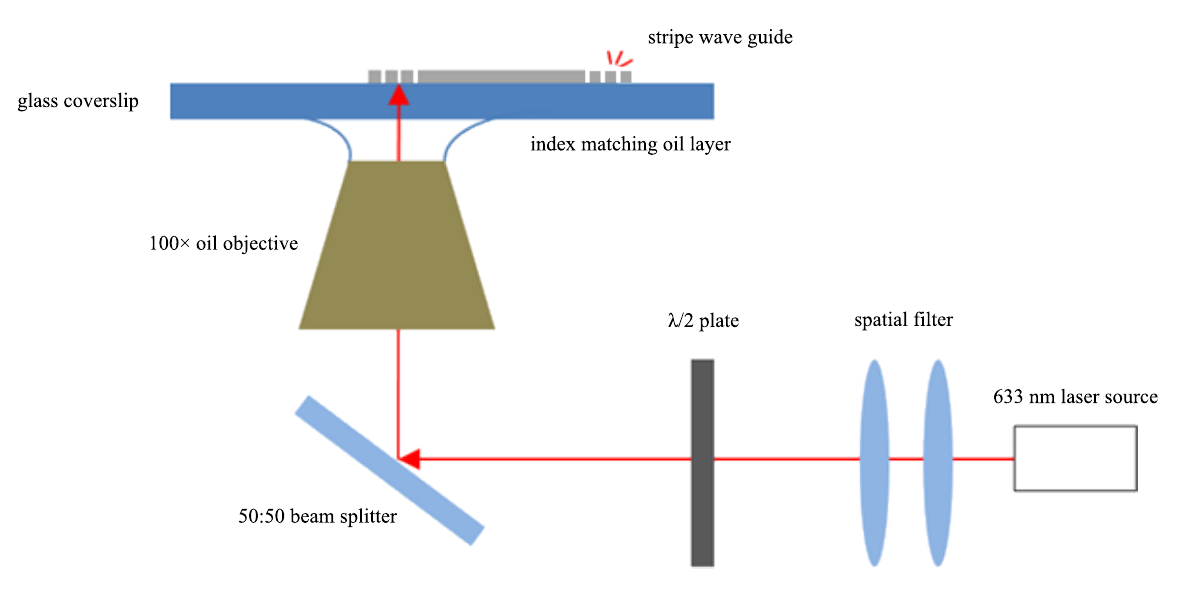
Figure 3: Conceptual representation of the excitation setup. The stripe waveguide is excited using the input gratings and light outcoupling is observed at the opposite end.